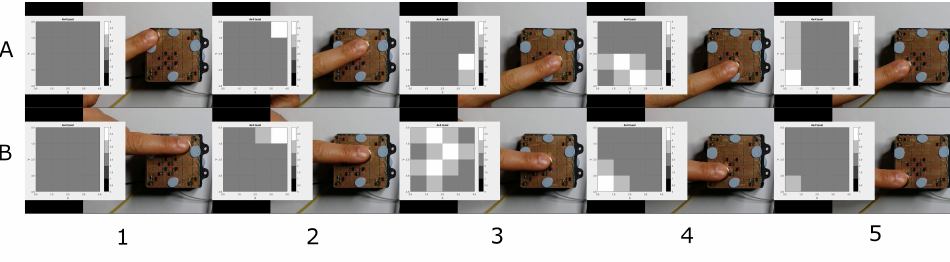
Figure 6. ( A ) Sequence of magnet circular movement (outer edge circle clockwise). ( B ) Sequence of diagonal movement from top right to bottom left corner.